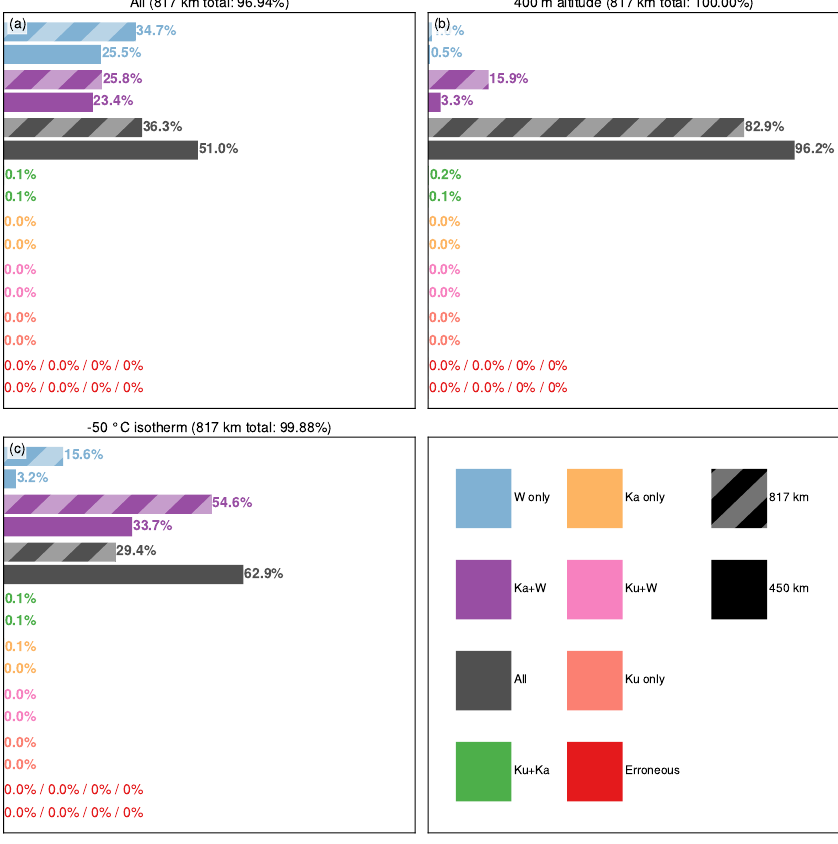
Figure 15. As in Fig. 4, but limited to the region of Fig. 14 (Sect. 5.6; ASF in Fig. 3), and showing the − 50 ◦ C isotherm instead of 3 and − 15 ◦